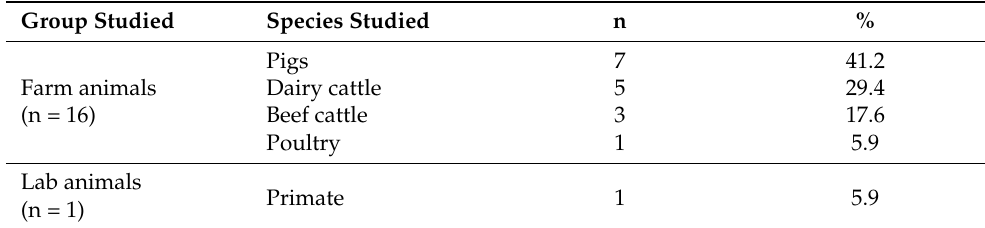
Table 5. Number and percentage of publications by group and species of animals studied.